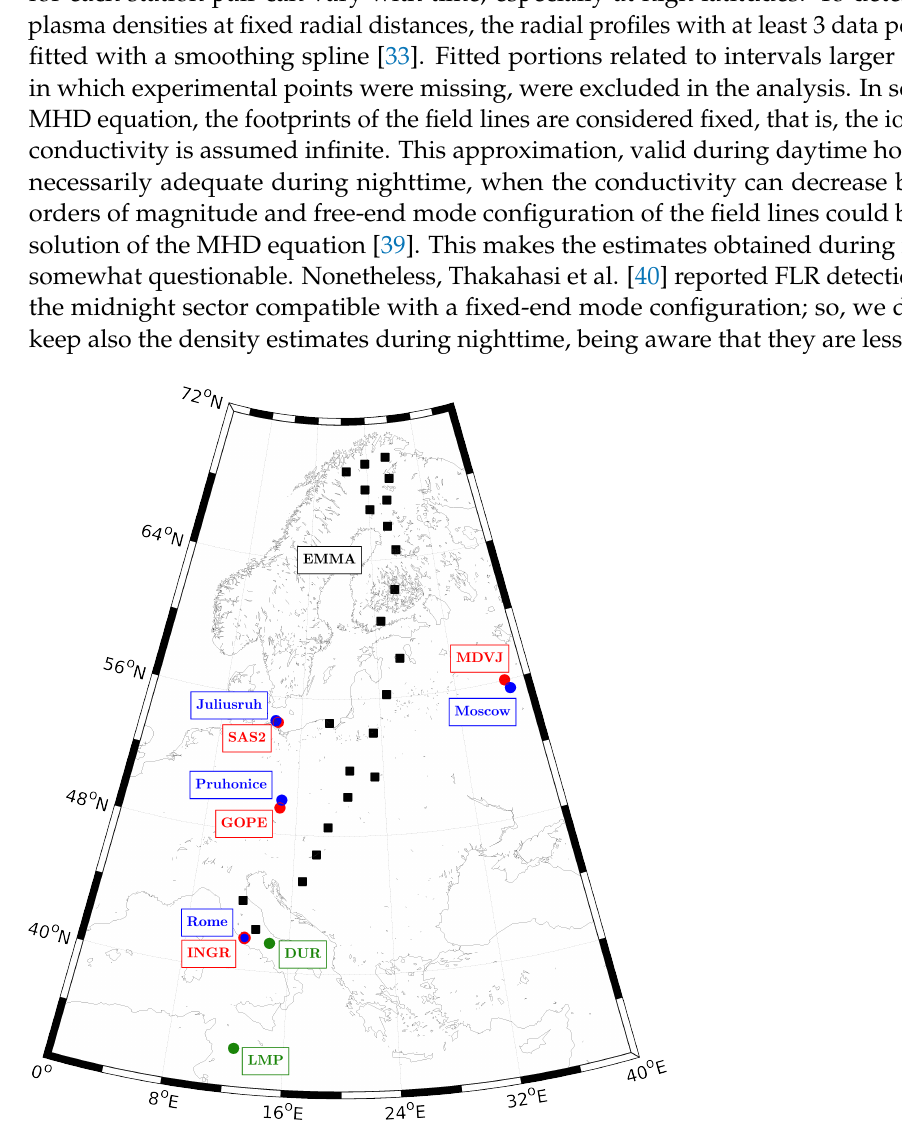
Figure 1. Position of the ground-based instrumentation used to perform the analysis in the European sector. Black squares are EMMA stations, blue dots are ionosonde stations, red dots are GNSS receivers and green dots are geomagnetic observatories. See text for further